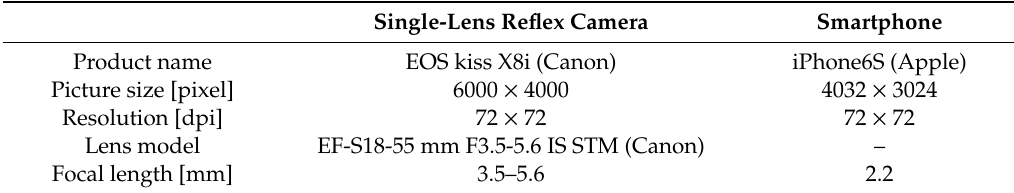
Table 1. Shooting equipment